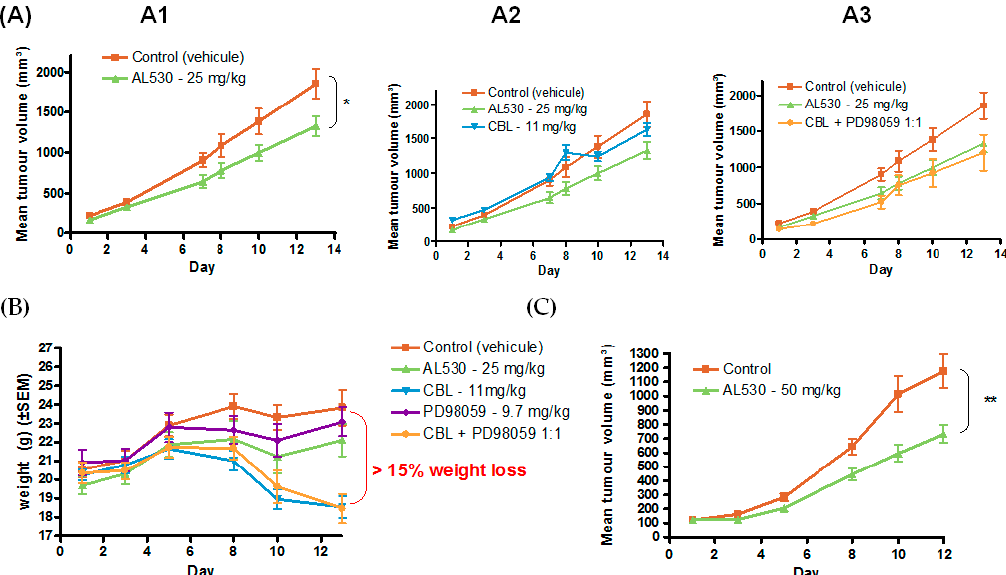
Figure 6. Effect of vehicle, AL530, Chlorambucil (CBL), PD98059 (MEK inhibitor) or equimolar combination CBL + PD98059 treatment on tumors growth ( A , C ) and weight ( B ) properties of CAL33 head and neck cancer cell xenograft. Nude mice ( n = 7 per group) bearing subcutaneous 200 mm 3 (at the start of the experiment) bilateral CAL33 tumors xenograft received either saline (orange square, A1 ), 25 mg/kg ( A1 ) or 50 mg/kg ( C ) of AL530 (green triangle), or 11 mg/kg of CBL ( A2 , blue diamond), or 9.7 mg/kg of PD98059 (data not shown) or an equimolar combination of CBL + PD98059 (1:1; A3 , orange circle) daily by i.p. route/q5d throughout the experiment. Data are expressed as mean ± SEM. ** p < 0.0001 and * p < 0.01, Mann–Whitney posthoc test.